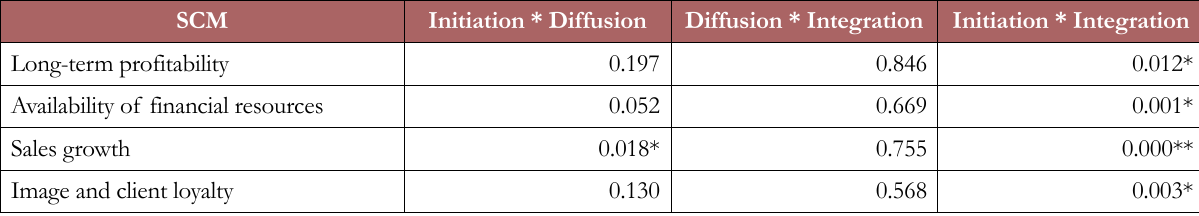
Table 8. Bonferroni test between adoption level groups and